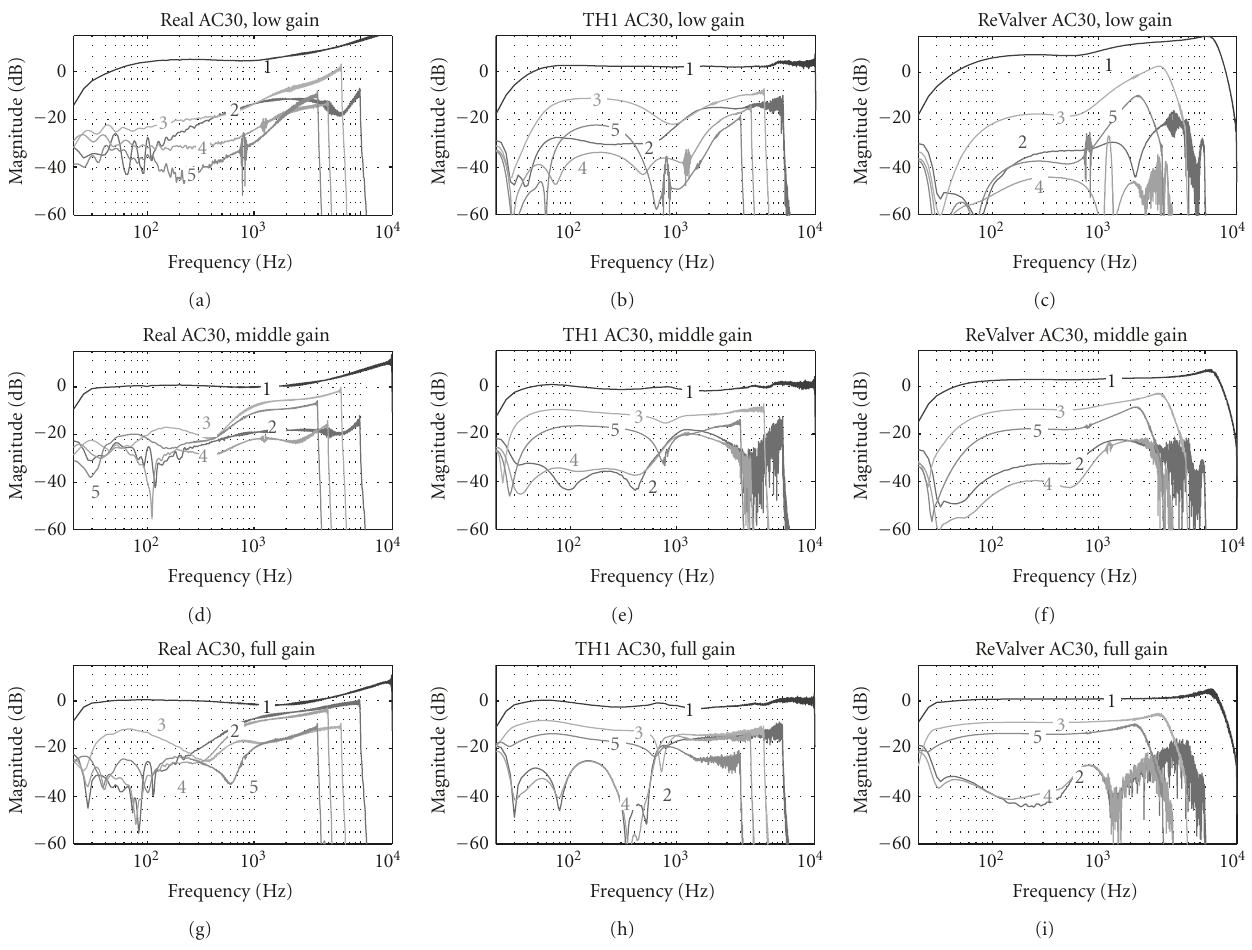
Figure 7: Logsweep analysis of the real AC30 (left column), the TH1 AC30 (middle column), and the ReValver AC30 (right column). The gain knob was first set to 9 o’clock (top row), then to 12 o’clock (middle row), and finally to full (bottom row). The numbered curves represent the order of the distortion, so that curve 1 corresponds to the linear magnitude response, curve 2 to the 2nd order harmonic distortion, curve 3 to the 3rd order harmonic distortion, and so forth. The 6th order and higher distortion components are not